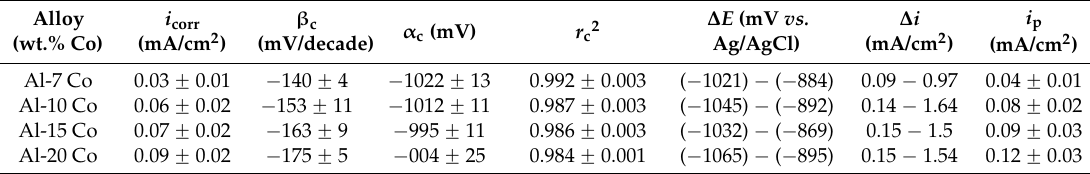
Table 4. Data extracted from Tafel extrapolation on the polarization curves of the Al-Co alloys: i corr , corrosion current density; β , the Tafel slope; α , constant in Tafel equation; r 2 , regression coefficient of the linear fit; ∆ E , overpotential range for the linear fit; ∆ i , current density range for the linear fit; index c, cathodic polarization curves. Additionally, i p , current density in the middle of current limiting stage 2.